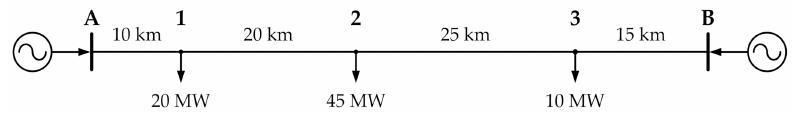
Figure 1. Diagram of a simple two-sided supplied